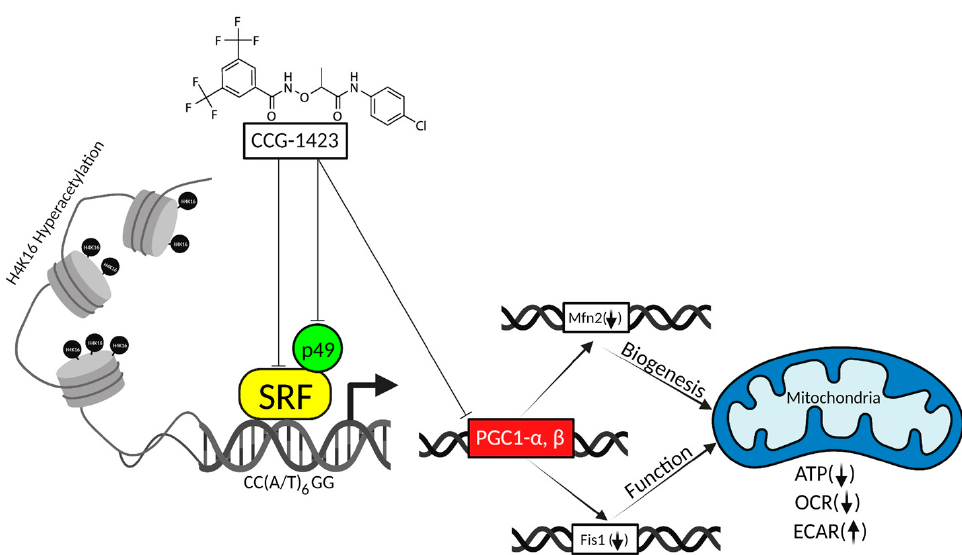
Figure 7. Schematic demonstrating the effects of CCG-1423 on mitochondria function. CCG-1423 inhibits SRF, p49/STRAP and PGC1- α , β , and causes H4K16 hyperacetylation, which modulates the functional activity of oxidative phosphorylation, glycolysis, and total ATP. Arrows indicate: ↑ = increase, ↓ = decrease, and = inhibition.